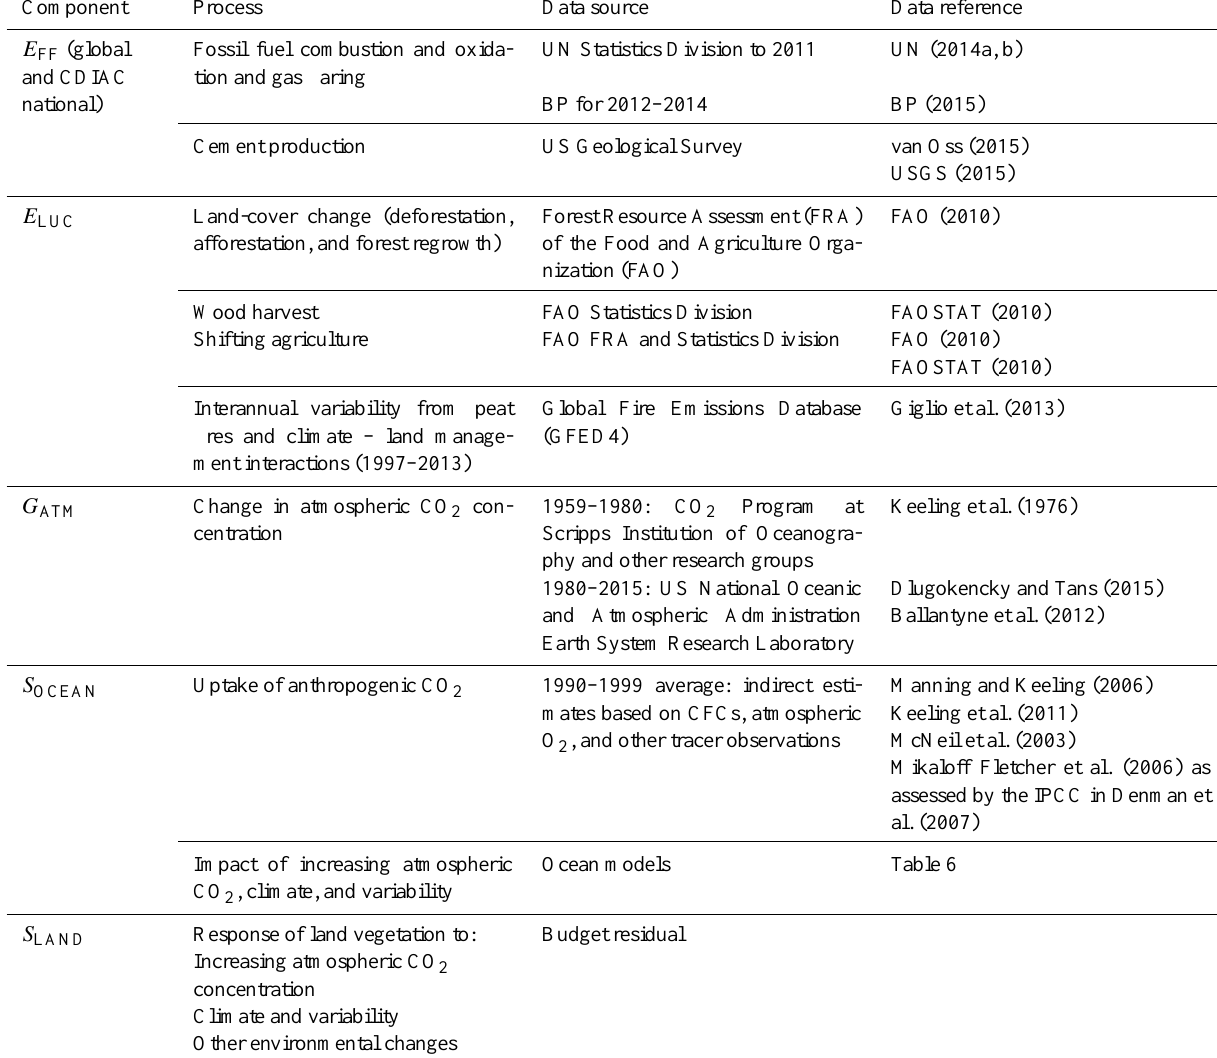
Table 4. Data sources used to compute each component of the global carbon budget. National emissions from UNFCCC are provided directly and thus no additional data sources need citing in this